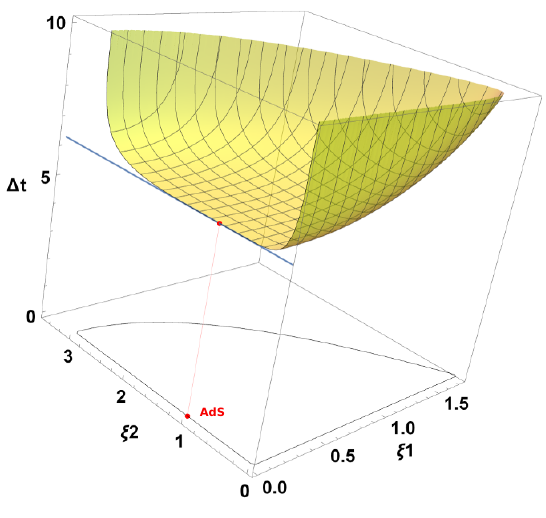
p 3 and 0 < (cid:24) 2 < 3 (cid:0) (cid:24) 2 . The 1